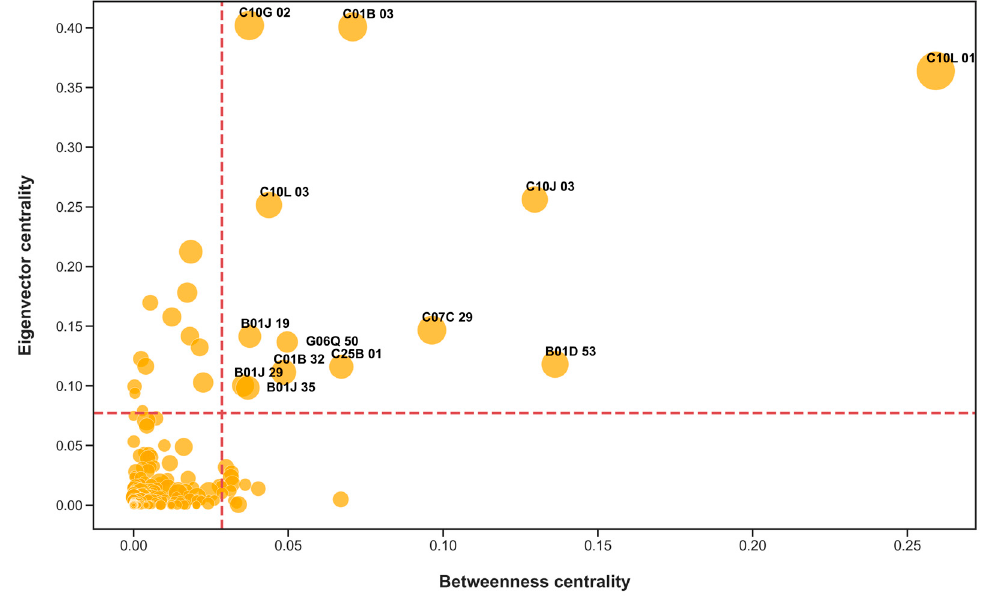
Figure 10. Matrix model applied to the e-fuel patent landscape. (Note: The x-axis represents the betweenness centrality, while the y-axis represents the eigenvector centrality). Table 4. Selected list of knowledge areas pertaining to each role. (Note: To not overwhelm the readers with too many details on the “No specific role”, only a partial list of knowledge areas has been provided).